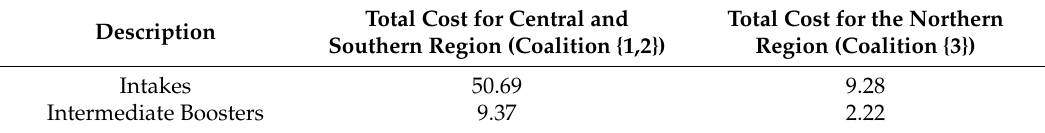
Table 10. Costs in game r A2,2 .